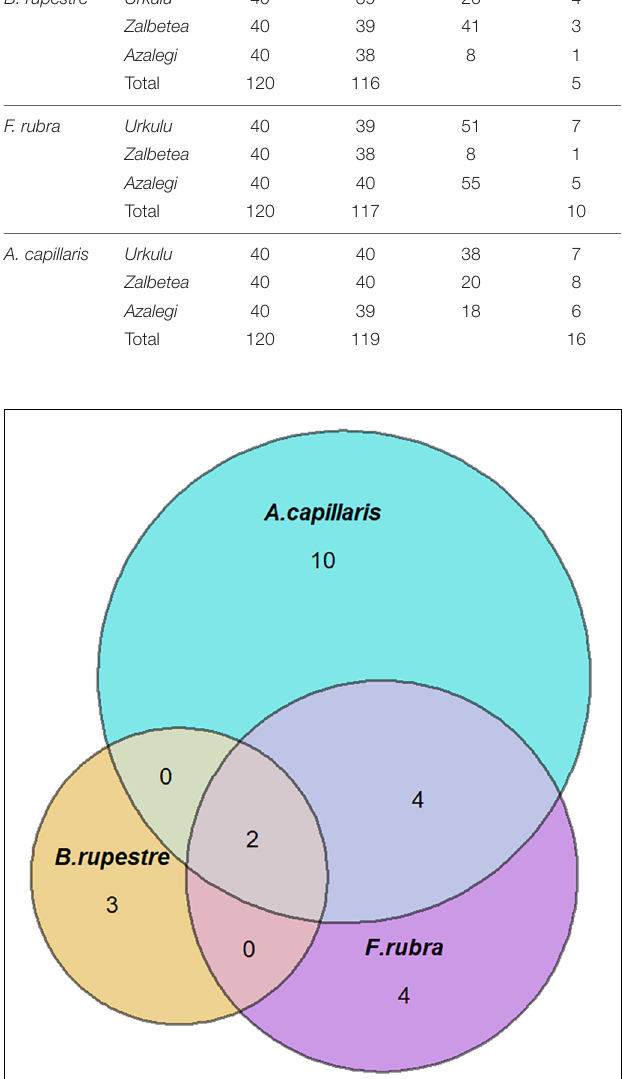
FIGURE 7 | Venn’s diagrams indicating the number of shared fungal endophyte species among grass species.